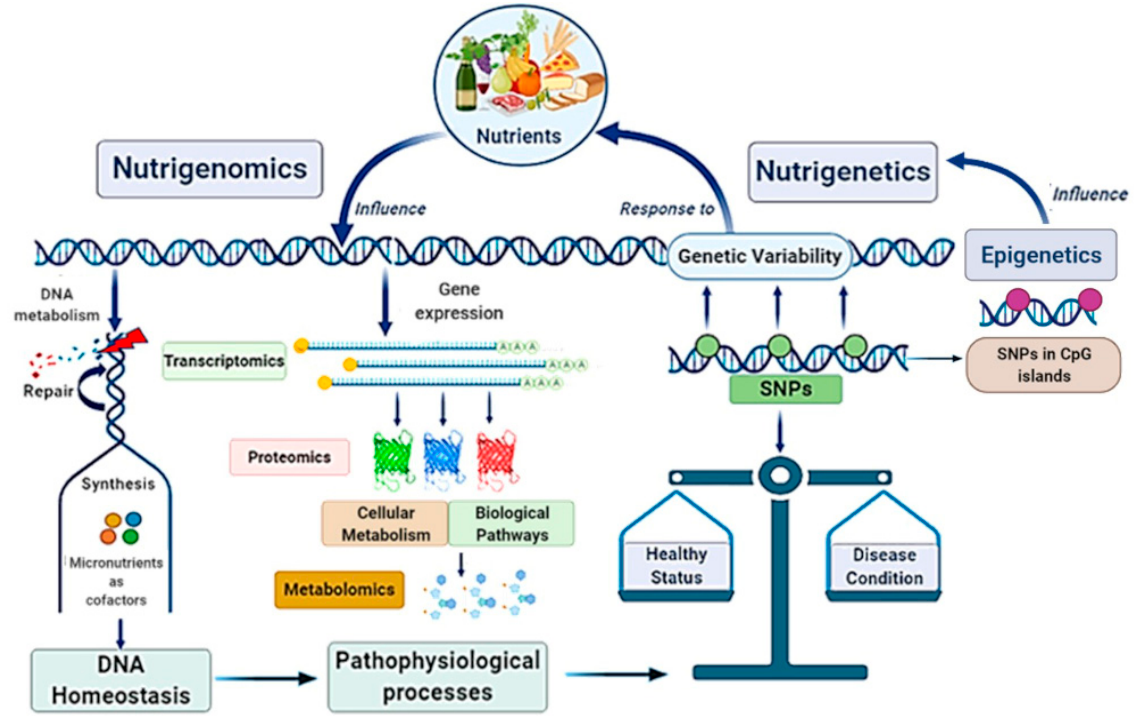
Figure 2. Nutrigenomics and nutrigenetics: two sides of the same medal with several linked approaches. Genome influences the responsiveness to nutrients (nutrigenetics’ field); at the same time, nutrition can also modify gene expression involving epigenetic mechanisms (nutrigenomics’ field). Nutrigenomics investigates the effects deriving from the interaction between the nutritional environment and inherited factors. Given the complexity of the scenario, nutrigenomics quests include several approaches involving many other disciplines. Nutritional factors and genetic ones influence each other: on one side, nutrients affect DNA metabolism, gene expression, and genetic variability; on the other side, genetic variants (as SNPs), by determining specific individual genotype, influence dietary habits. In turn, nutrigenetics could also be influenced by epigenetics. Altogether, these mechanisms contribute to determinate the status of health or a condition disease. SNPs, Single Nucleotide